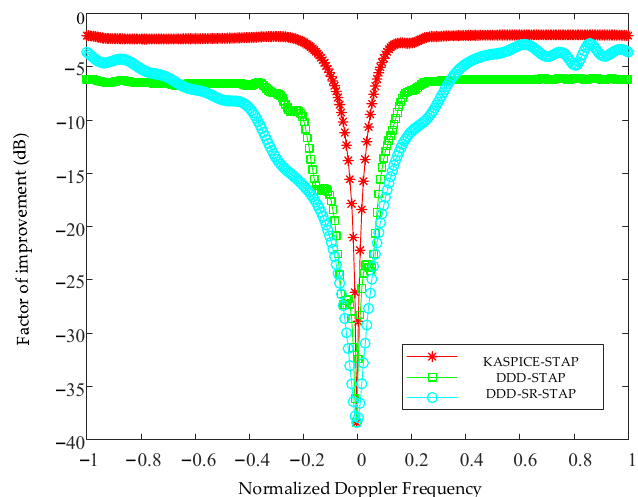
Figure 8. Factor of improvement curve of No. 60 range unit.